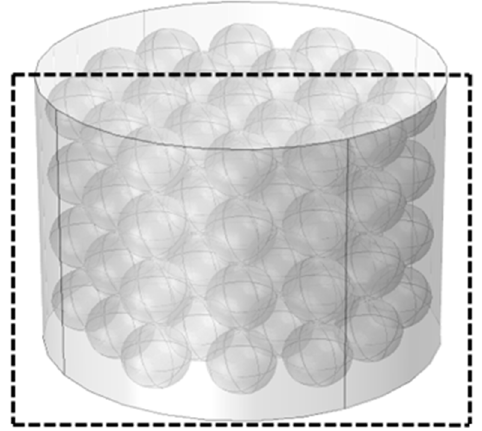
Figure 2. Schematic diagram of a tristructural-isotopic (TRISO) particle characteristic unit. IPyC, inner pyrocarbon; OPyC, outer pyrocarbon.